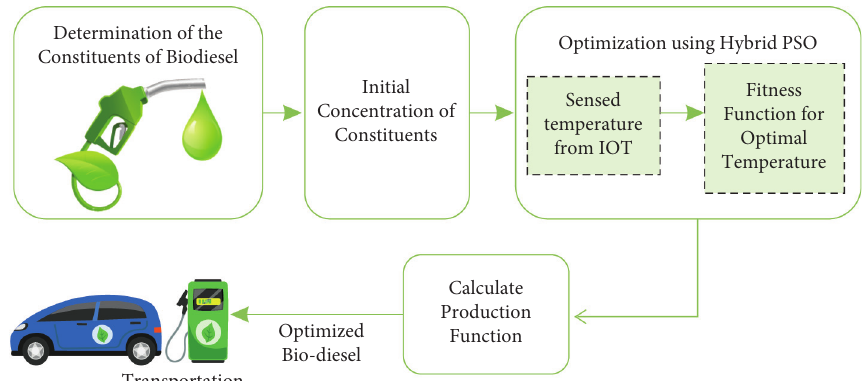
Figure 1: Block diagram for the proposed work.